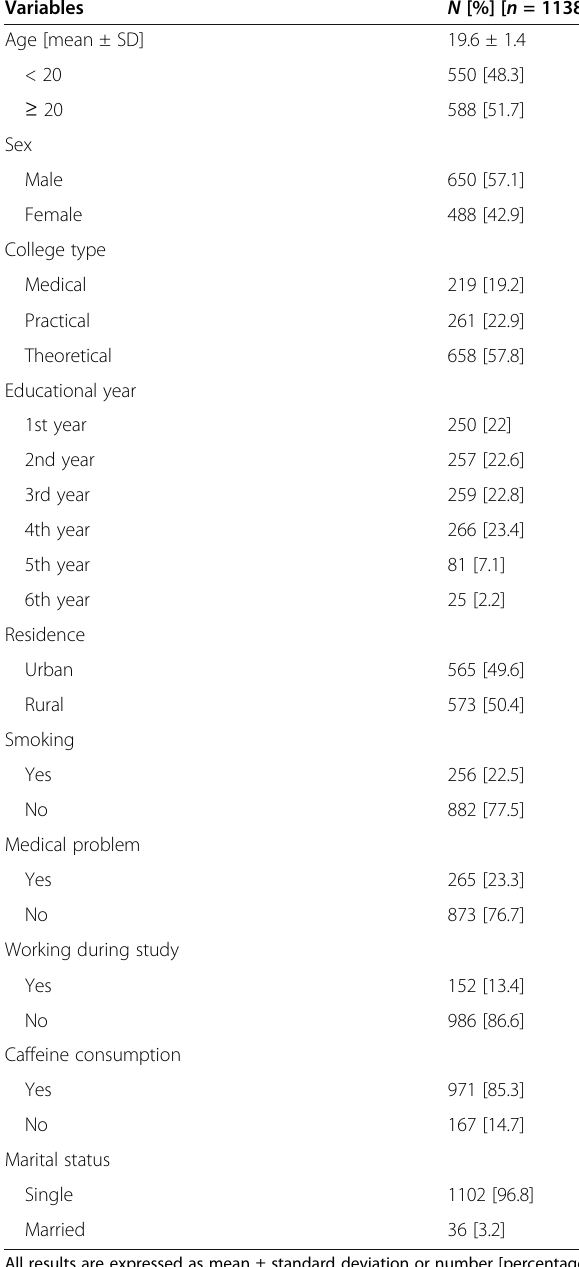
Table 1 Socio-demographic characteristics of studied Egyptian students in Mansoura